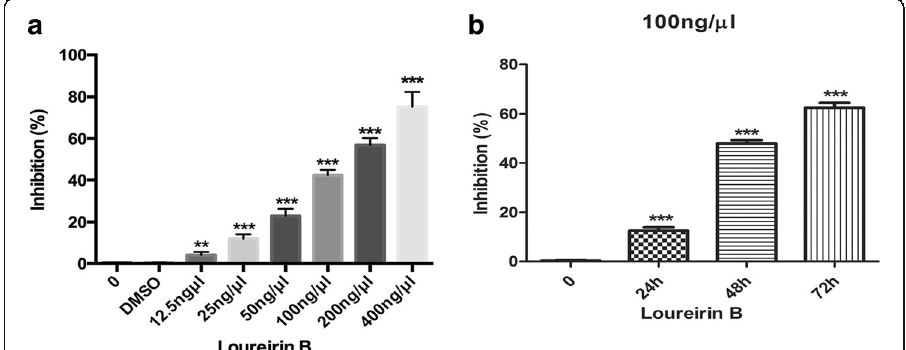
Fig. 1 Loureirin B inhibits the proliferation of HSCs. a Activated hepatic stellate cells (aHSCs) were treated with 12.5, 25, 50, 100, 200 or 400 ng/ μ l loureirin B for 48 h, and then detected using the MTT assay. b aHSCs were treated with 100 ng/ μ l loureirin B for 24, 48 and 72 h, and then detected using the MTT assay. The